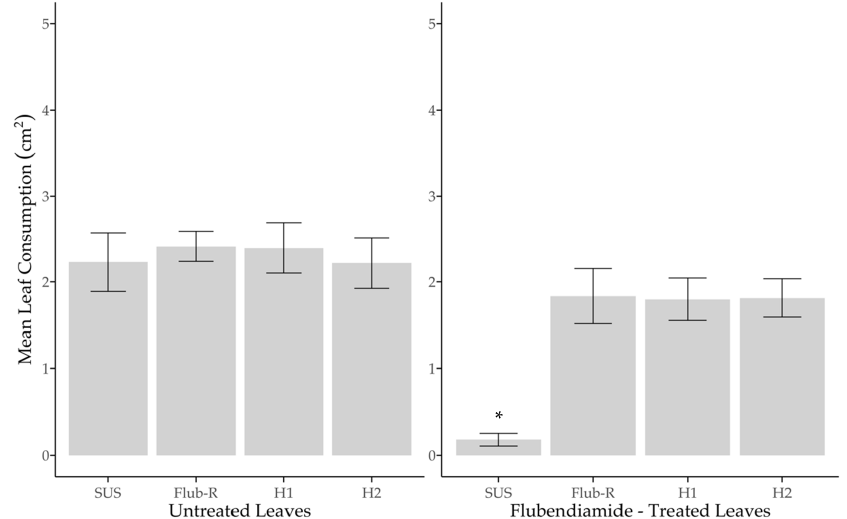
Figure 3 . Mean leaf consumption by susceptible (SUS), resistant (Flub-R) and heterozygous H1 ( ♀ SUS X ♂ Flub-R) and H2 ( ♀ Flub-R X ♂ SUS) H. armigera larva in soybean leaves untreated and flubendiamide-treated (0.33 μ g a.i. cm − 2 ). * Significant difference between strains according to the Tukey test ( p < 0.05).